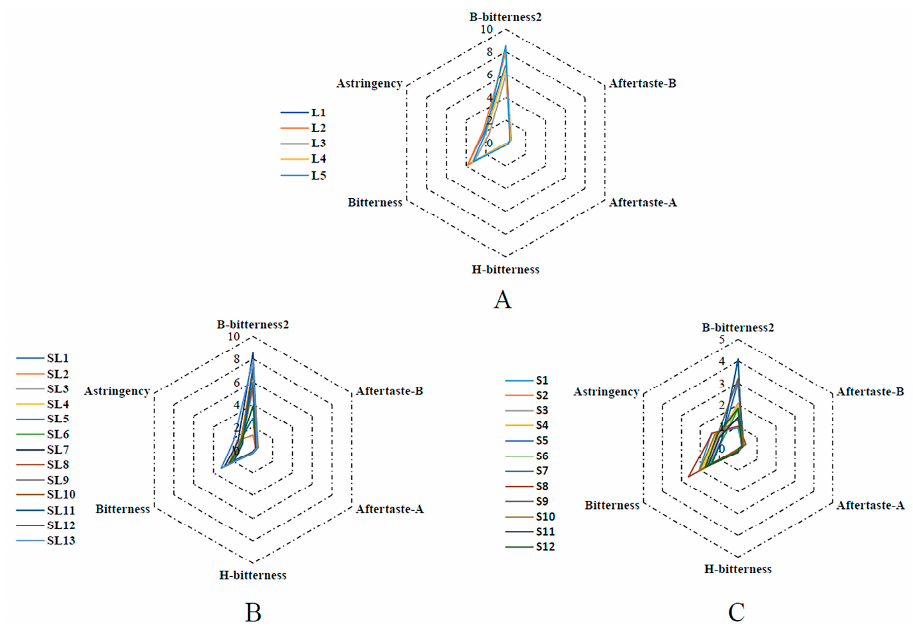
Figure 1. Radar curves of Andrographis Herba (AH) samples’ bitterness for different commercial classifications. A: Leaf samples, B: Stem/Leaf samples, C: Stem samples.